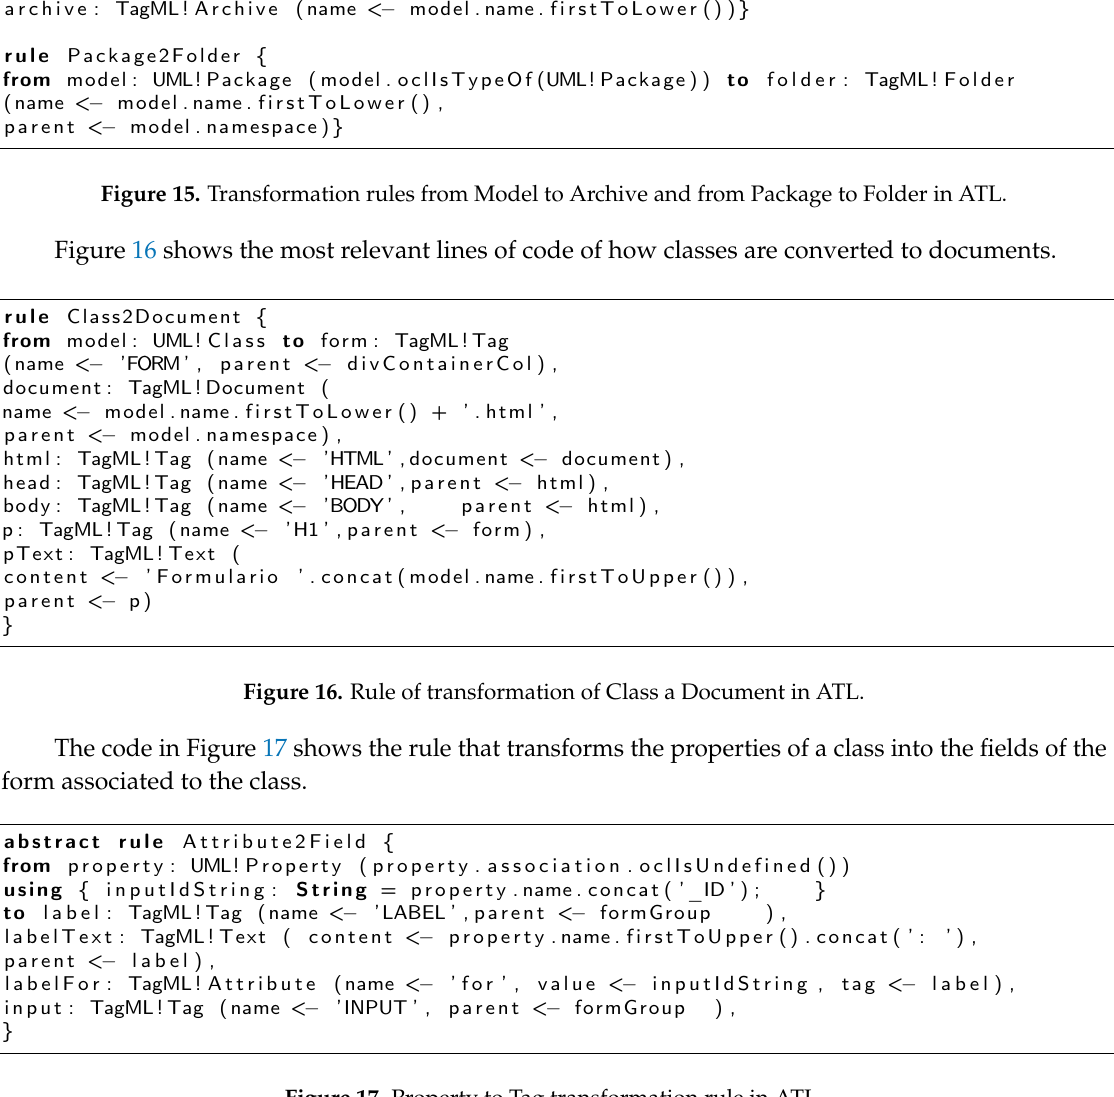
Figure 17. Property to Tag transformation rule in